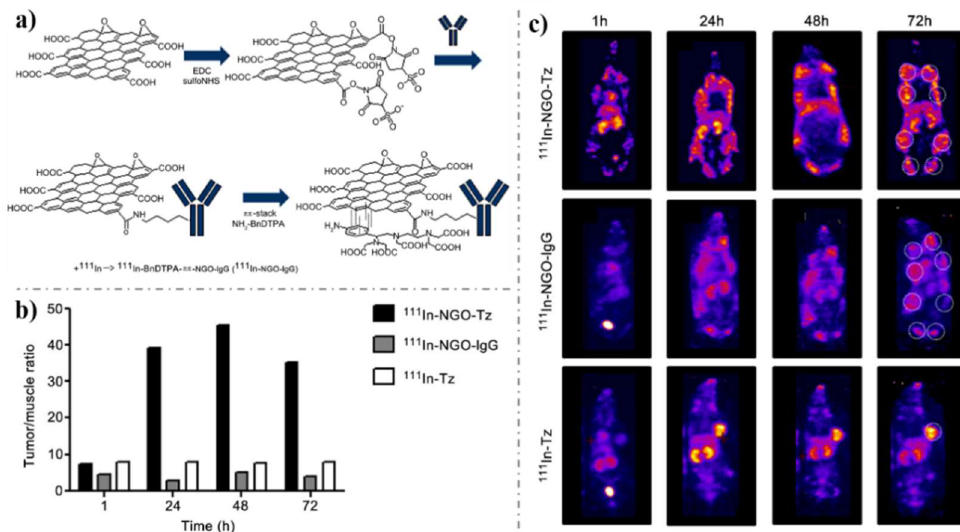
Figure 10. ( a ) Synthesis of 111 In-NGO-IgG or 111 In-NGO-Tz. ( b ) Quantification of the biodistribution of the mice in c . ( c ) Representative whole-body SPECT images (MIPs) of the biodistribution of 111 In-NGO-Tz, 111 In-NGO-IgG, or 111 In-Tz in spontaneous tumor-bearing BALB/neuT mice at 1, 24, 48, or 72 h i.p. injection. Tumors are located in mammary fat pads, with metastases in the axial and inguinal lymph nodes (white dashed circle in 72 h images). Tumor burden is likely different in each animal due to the nature of the spontaneous tumor model. Reproduced from [179], with permission from Elsevier, 2013.